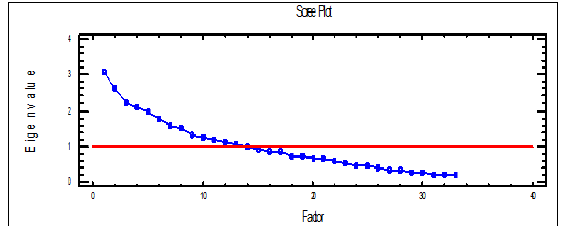
Figure 1. The dependence of the eigenvalue from the number of factors